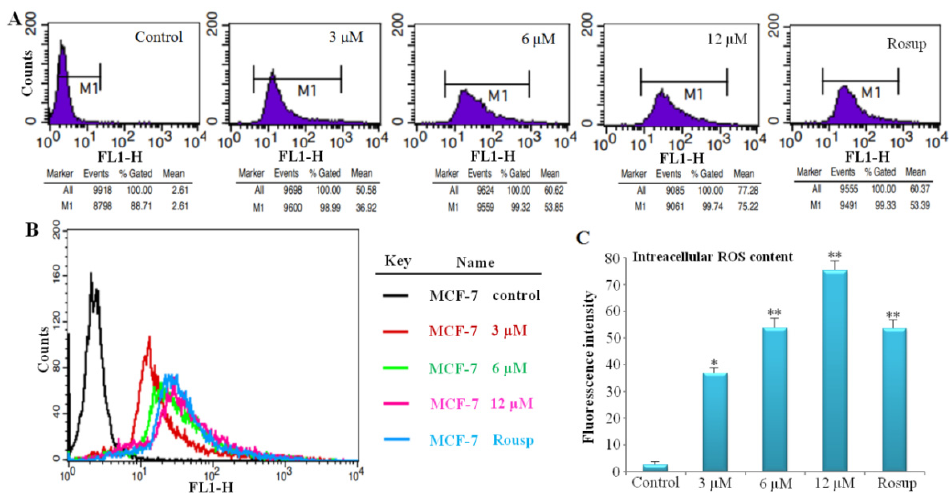
Figure 7. Effects of compound 8f on intracellular ROS level in MCF-7 cells. MCF-7 cells were co-cultured with 8f (0, 3, 6 and 12 μ M) for 24 h, stained with H 2 DCFDA and analyzed by flow cytometry. ( A ) Representative flow cytometric histograms of ROS level. ( B ) The histograms were merged together. ( C ) The bar graph represents the intracellular ROS level at different concentrations of 8f . Data were revealed as the means ± SD for independent tests in triplicate. * p < 0.05, ** p < 0.01 vs. control ( 8f 0 μ M) group.